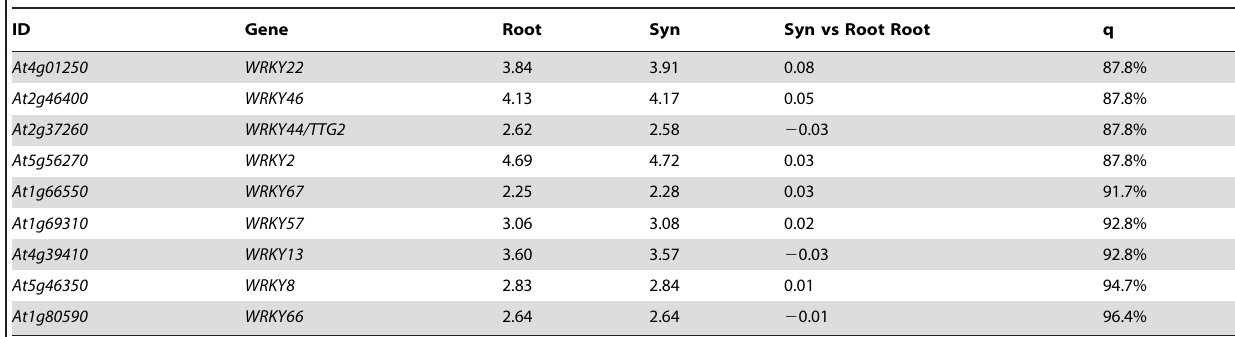
The data for microaspirated syncytia at 5 dpi and 15 dpi were compared with control root segments (containing elongation zone without root tip). Columns 3 and 4 contain normalized expression values on a log 2 scale. Column 5 shows the differences (fold changes) between the pairwise samples as normalized log 2 ratios (see the Online Methods section for details). The q-values in column 6 indicate significance after correction for multiple testing controlling the False Discovery Rate. Genes with a significant up- or down-regulation (q , 5%) are marked in bold in column 6. Genes with significant down-regulation are in addition shown with the gene symbol in